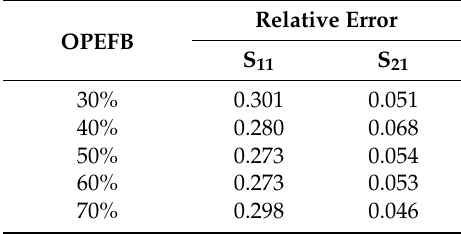
Table 2. The mean relative error of S 11 and S 21 for OPEFB / PLA composite. Relative OPEFB OPEFB